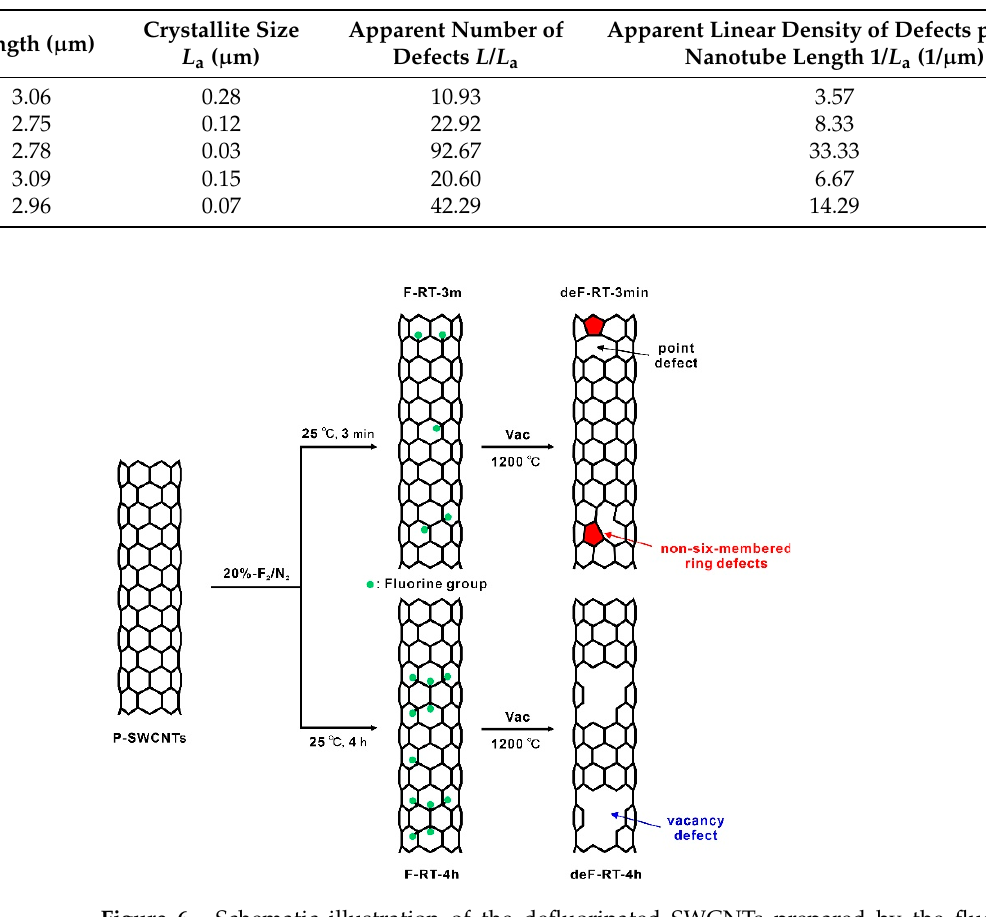
Table 2. Average nanotube length, crystallite size, apparent number of defects, and apparent linear density of defects per unit nanotube length of P-SWCNTs, deF-RT-3m, and deF-RT-4h. The Raman spectra of each sample were recorded at five different positions.